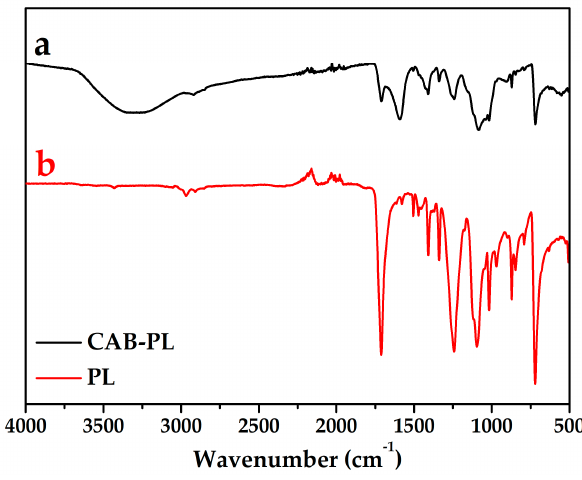
Figure 3. FTIR spectra of the ( a ) CAB-PL and ( b ) PL.